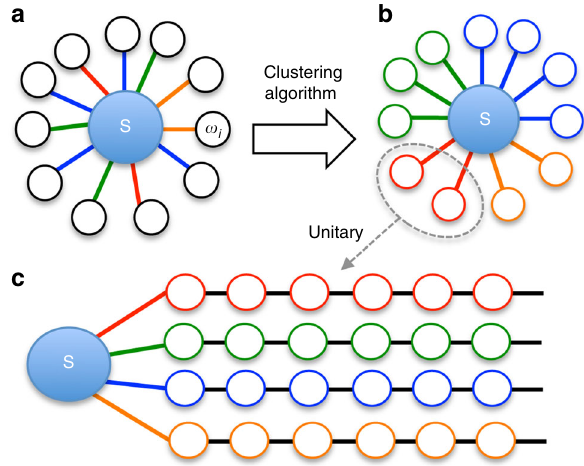
Fig. 2 Ab intio information processing and model extraction. a The ab initio linear vibronic Hamiltonian describes how each vibration mode of frequency ω i (outer circles) couples to the system (S). The coupling matrix for each mode could be different, shown as the colour of connecting lines. b A K-means learning (clustering) algorithm groups modes according to their common coupling type (colour grouping in fi gure). c A unitary transform (linear combination of vibration modes) of each cluster creates an equivalent nearest-neighbour chain representation of the Hamiltonian, ideal for tensor network